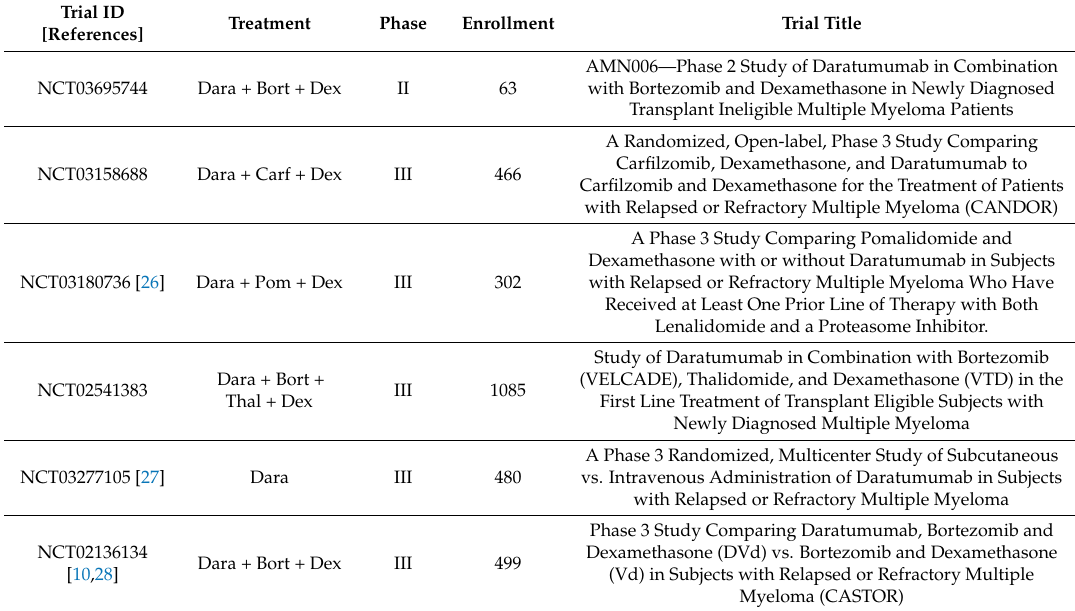
Table 1. Selected Active Trials of Daratumumab in Multiple Myeloma